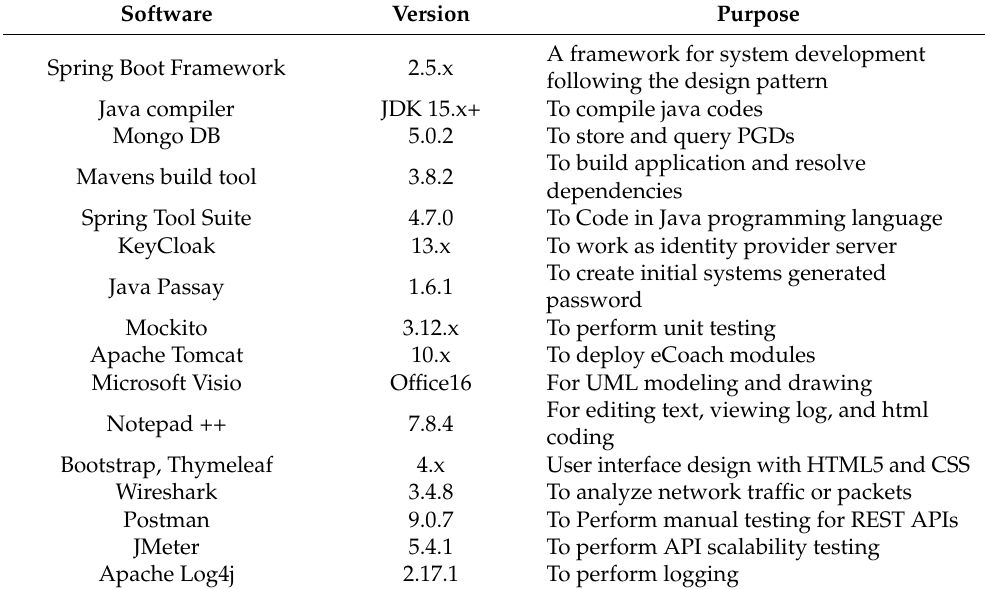
Figure 7. Sequence diagram of the login process for accessing web resources following the SSK security solution. Table 4. Scoped software, respective version, and usage.